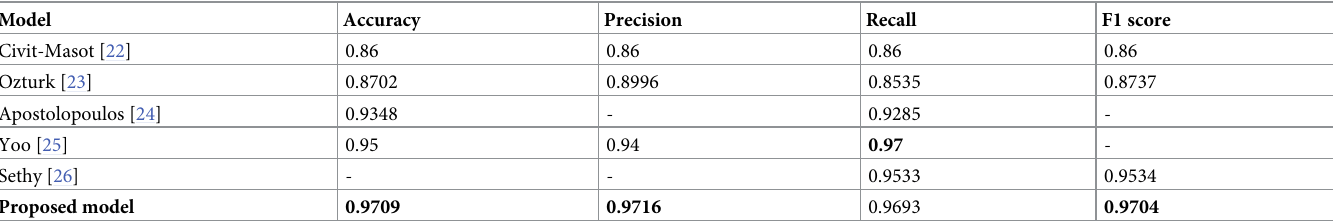
Table 4. Performance comparation of the proposed model with some other models regarding the detection of Covid-19.